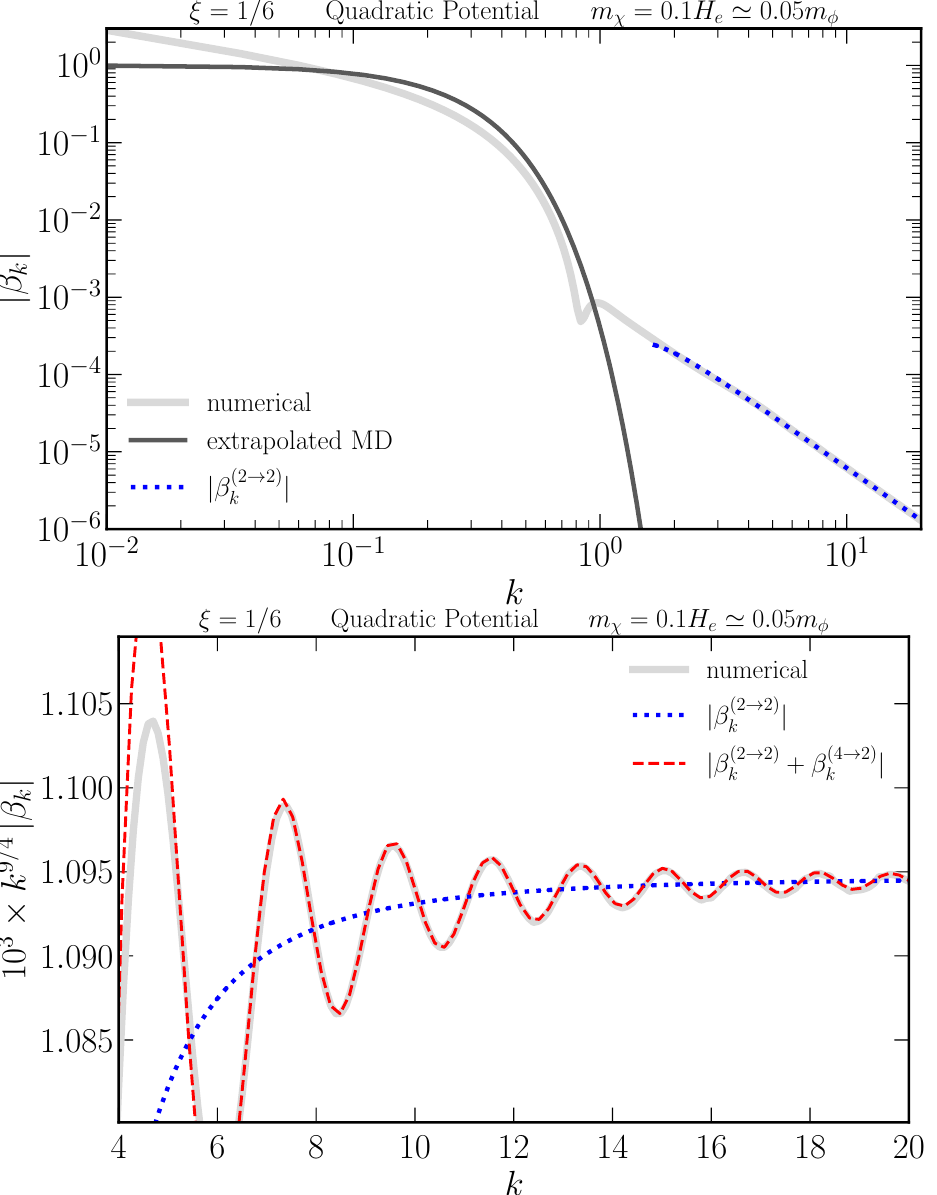
Figure 1 . The Bogoliubov coefficient | β k | as a function of comoving wavenumber k (with a e H e = 1 ) in the Quadratic Potential model. We assume a conformally-coupled ( ξ = 1 / 6 ) scalar spectator with mass m χ that experiences GPP due to an expanding spacetime background driven by an inflaton field φ on a quadratic potential with mass m φ . Top: we calculate | β k | using the analytic results derived in this work (blue-dotted) and using direct numerical integration of the mode equations (gray). Note that | β k | scales as k − 9 / 4 at large k . As a comparative contrast to this power law behavior in k , the black curve shows an approximate expression for | β k | for GPP in a matter dominated (MD) universe, extrapolated to lower k values (beyond the range of strict validity) for visual completeness of the exponential behavior. Bottom: the Bogoliubov coefficient exhibits an oscillatory feature in the large k power-law tail of the spectrum, which is explained in this work as a result of quantum interference between β (2 → 2)